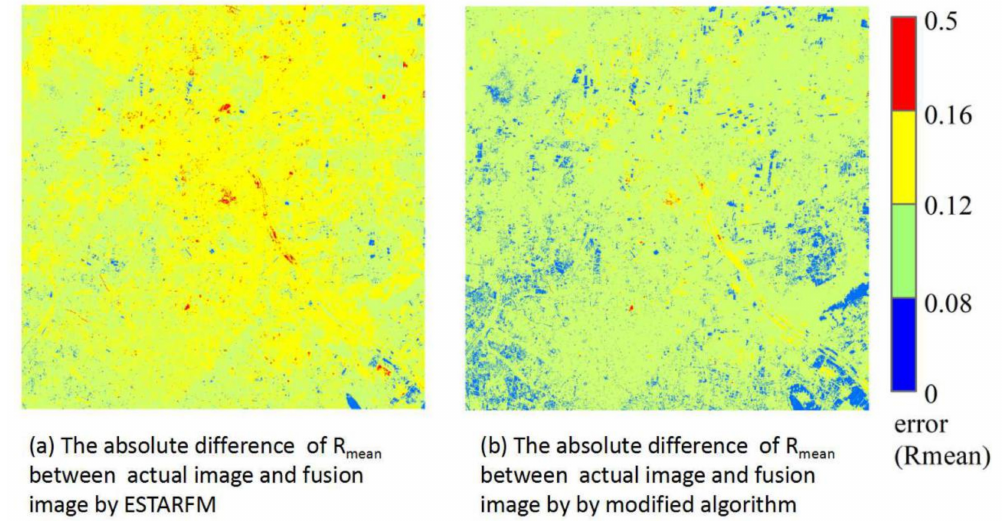
Figure 9. The comparison of the absolute di ff erence of R mean between the true observed image and the predicted image by ESTARFM ( a ) and the modified algorithm ( b ) in